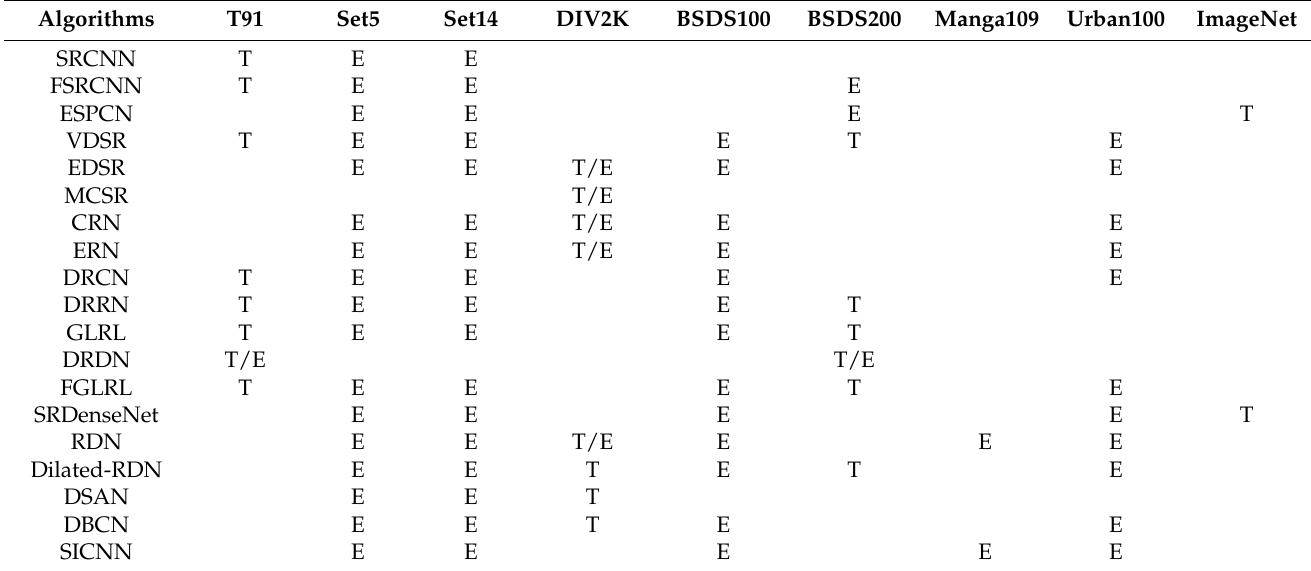
Table 2. List of algorithms used in different algorithms (T stands for training datasets whereas E stands for evalua- tion